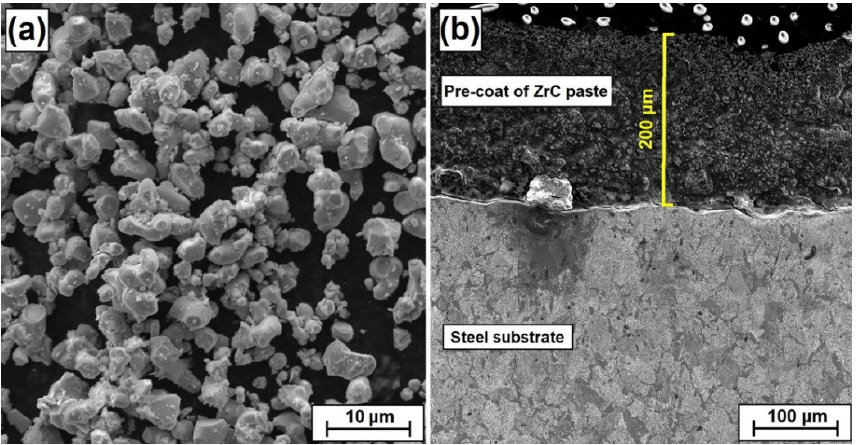
Figure 1. Morphology of zirconium carbide powder with average particle size less than 15 µm ( a ), zirconium carbide pre-coat applied on steel ( b ).